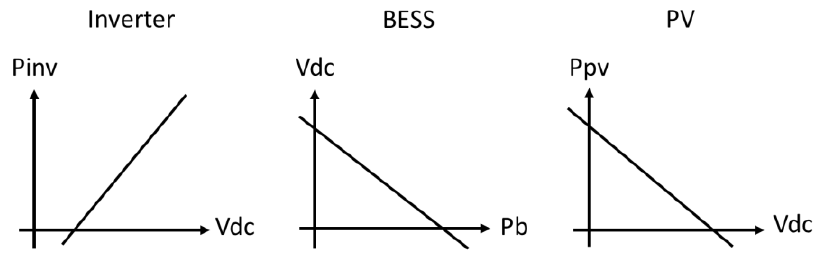
Figure 17. Droop controllers in the hybrid microgrid.